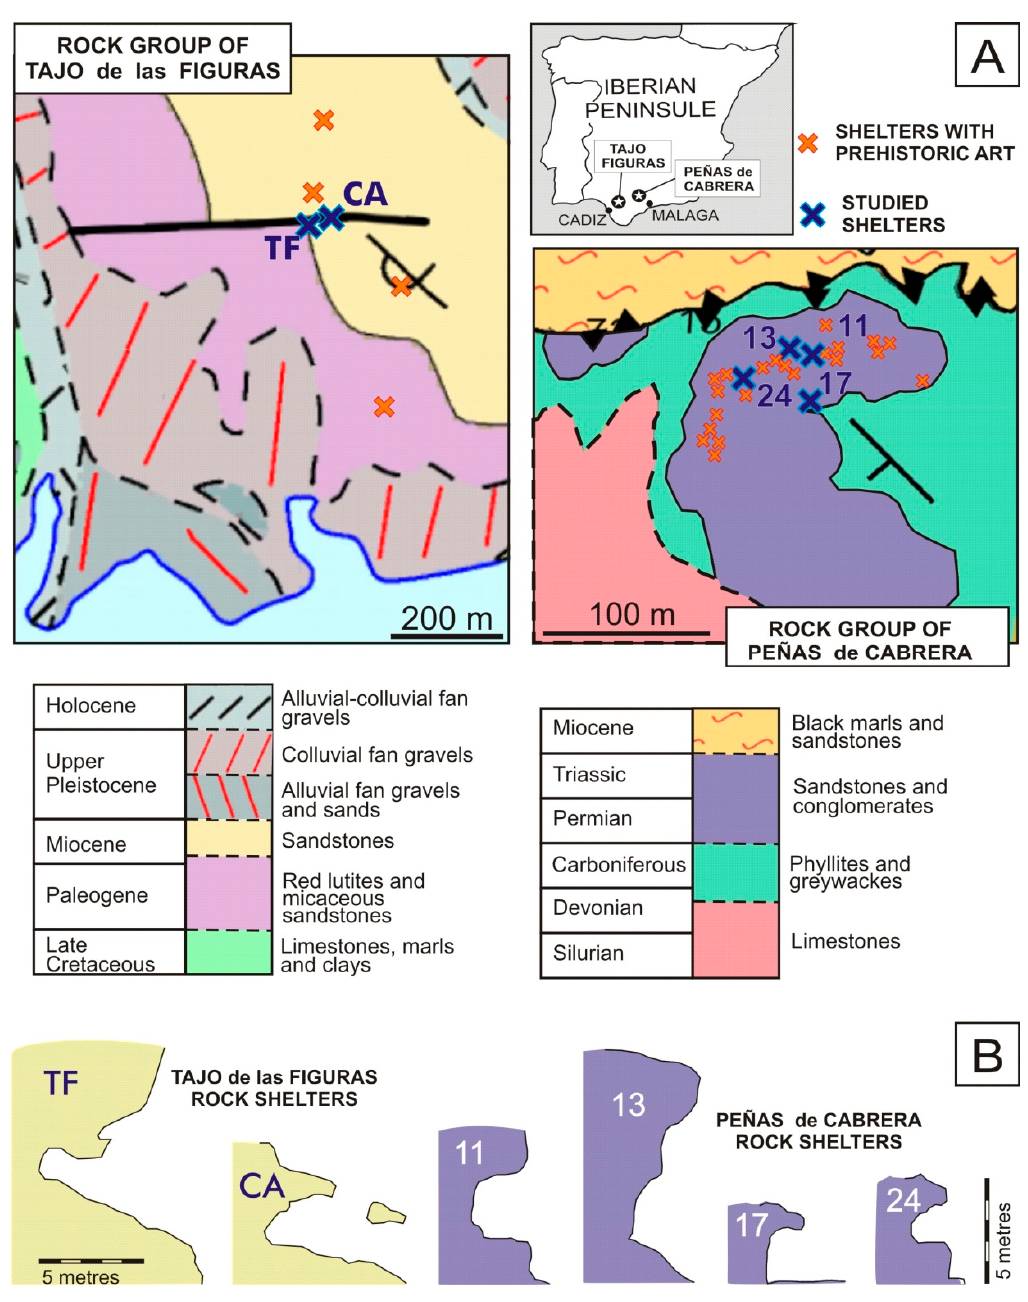
Figure 1. ( A ) Location map. Small crosses indicate locations of rock shelters with prehistoric paintings and engravings. Large crosses indicate locations of the studied rock shelters: Cueva del Tajo de las Figuras (TF), Cueva del Arco (CA), Shelter n o 11, Shelter n o 13, Shelter n o 17, and Shelter n o 24. ( B ) Cross-sections of the studied rock-shelters.